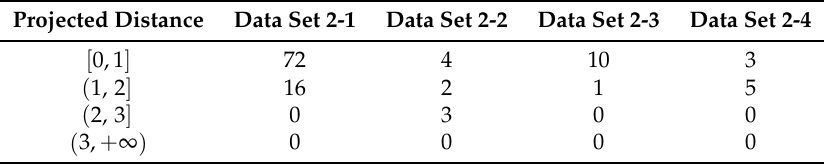
Table 4. Projected distance distribution of corresponding intersections of